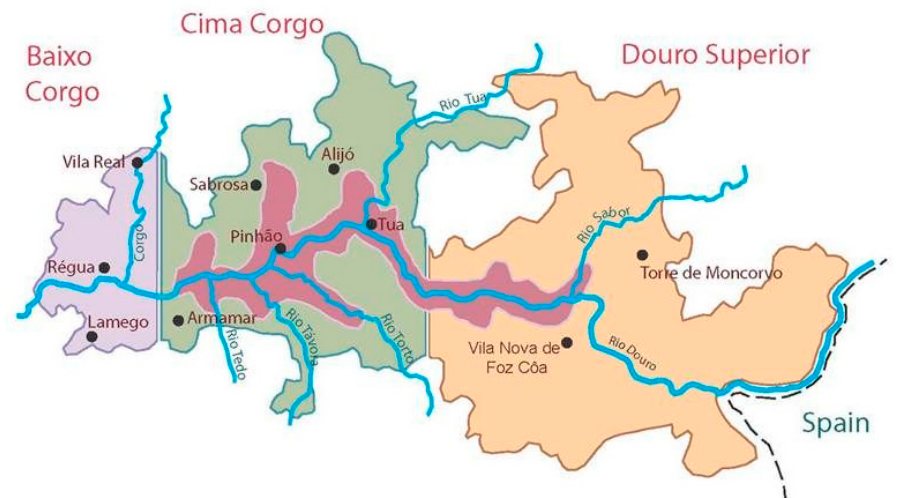
Figure 1. Sub-regions of the Demarcated Douro Region, Portugal.